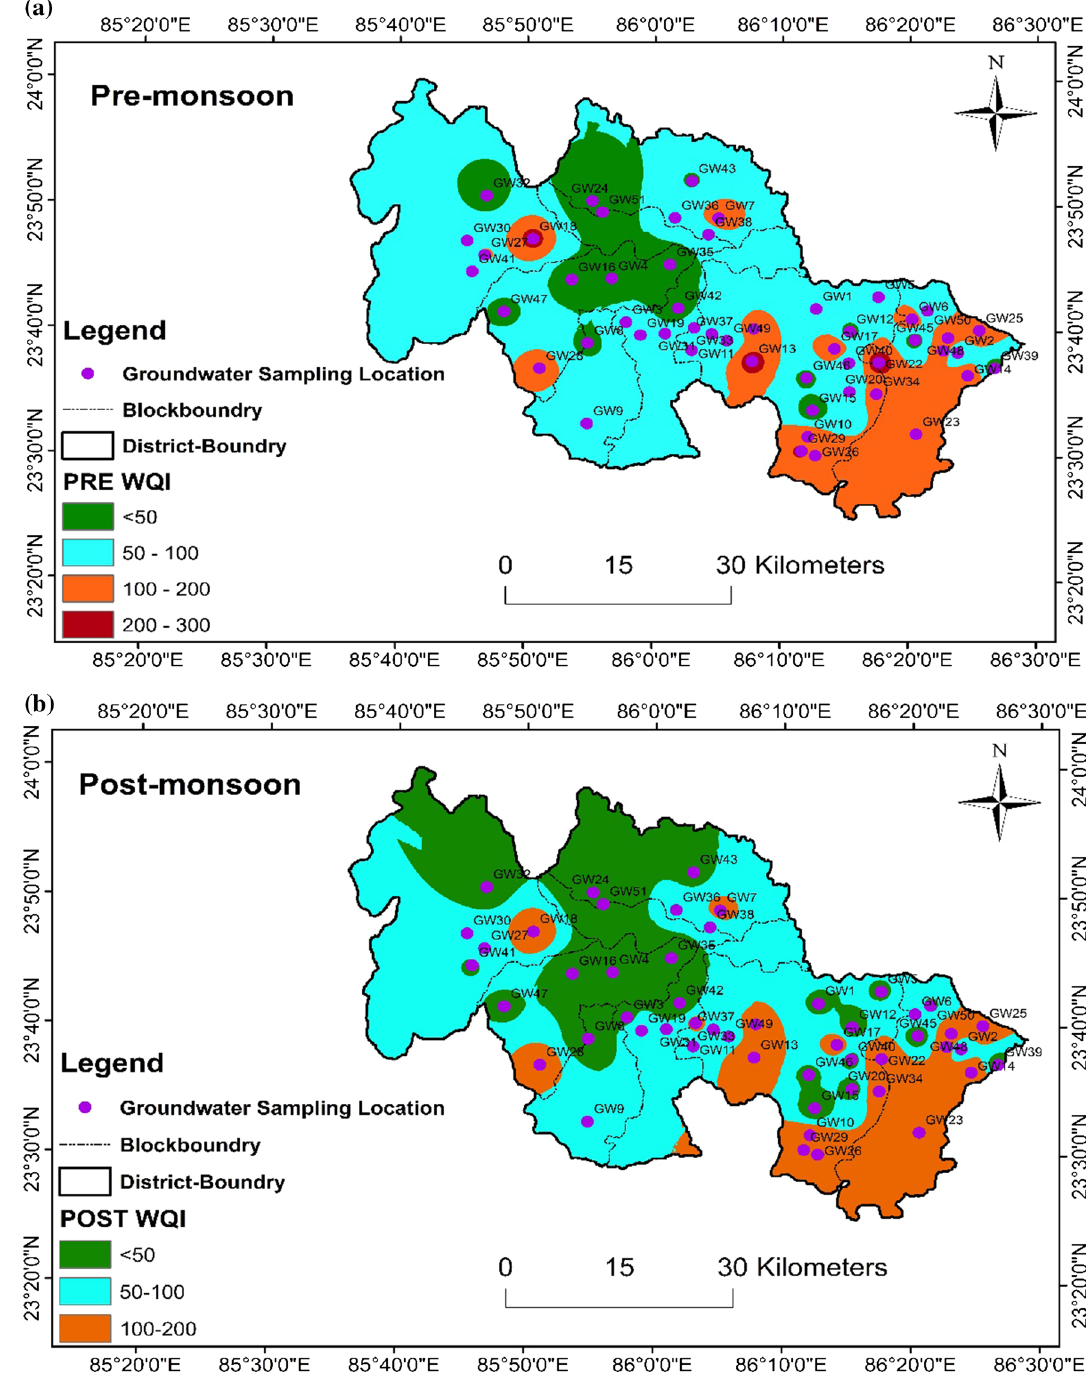
Fig. 8 Spatial distribution of WQI values in the groundwater of the Bokaro